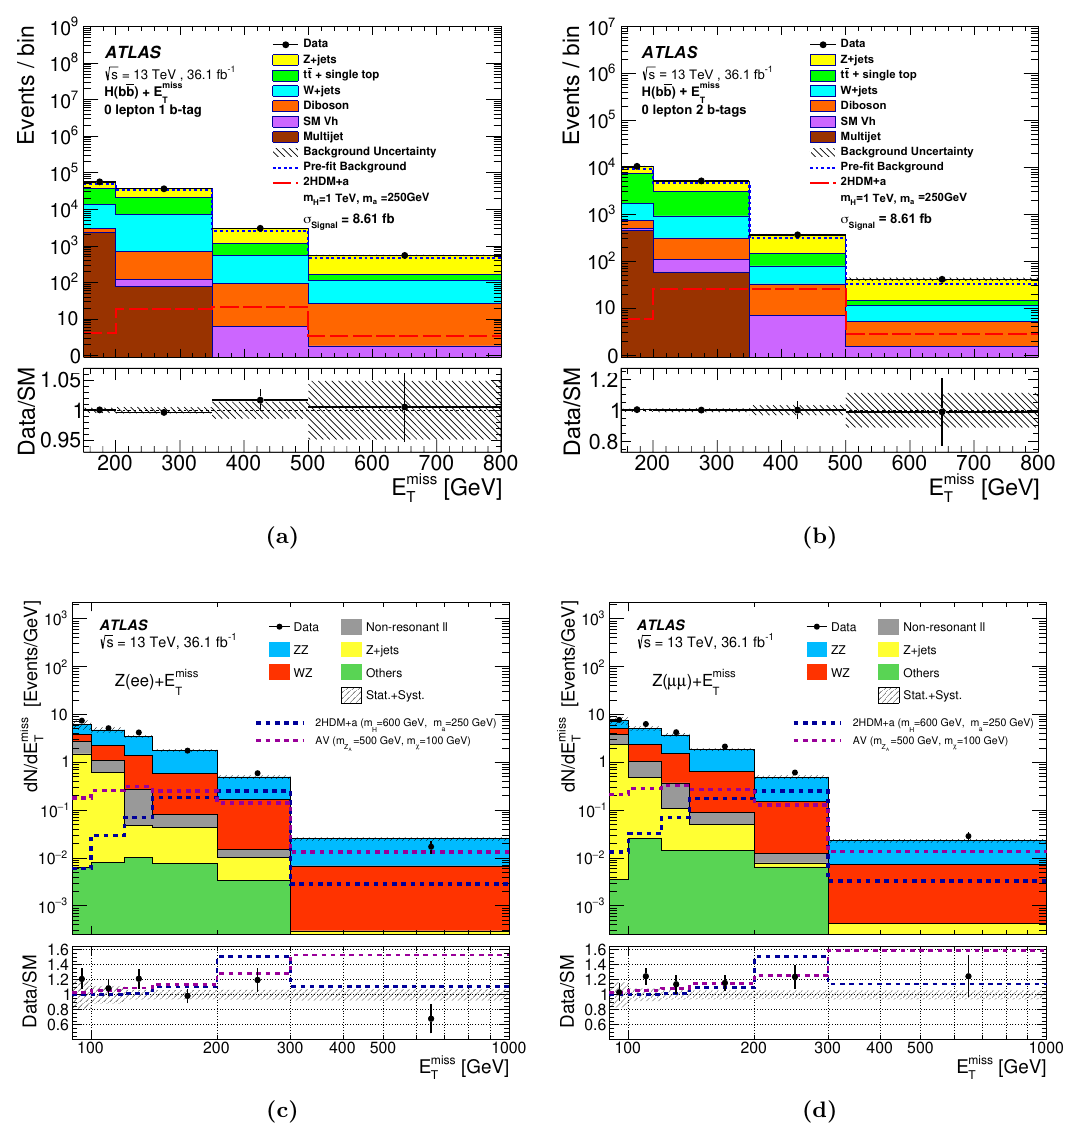
Figure 8. Observed E miss distribution in the h ( b (cid:22) b )+ E miss analysis in the (a) 1- b -tag and (b) 2- b -tag T T signal regions compared with the background predictions. The error bands show the total statistical and systematic uncertainties of the background predictions. The expected E miss distribution for a T representative signal model is also shown. It corresponds to a 2HDM+ a signal with m a = 250 GeV, m H = m H (cid:6) = m A = 1000 GeV, tan (cid:12) = 1 : 0, sin (cid:18) = 0 : 35, g (cid:31) = 1 : 0 and m (cid:31) = 10 GeV. Observed distribution in the Z ( ‘‘ ) + E miss analysis in the (c) ee and (d) (cid:22)(cid:22) signal regions compared E miss T T with the background predictions. The expected E miss distribution for representative signal models T are also shown. They correspond to a 2HDM+ a signal with m a = 250 GeV, m H = m = H (cid:6) m A = 600 GeV, tan (cid:12) = 1 : 0, sin (cid:18) = 0 : 35, g (cid:31) = 1 : 0 and m (cid:31) = 10 GeV, and an AV signal with = 500 GeV, m (cid:31) = 100 GeV, g q = 0 : 25, g ‘ = 0, and g (cid:31) = 1 : 0. The background predictions are m Z 0 A after the corresponding (cid:12)t in each